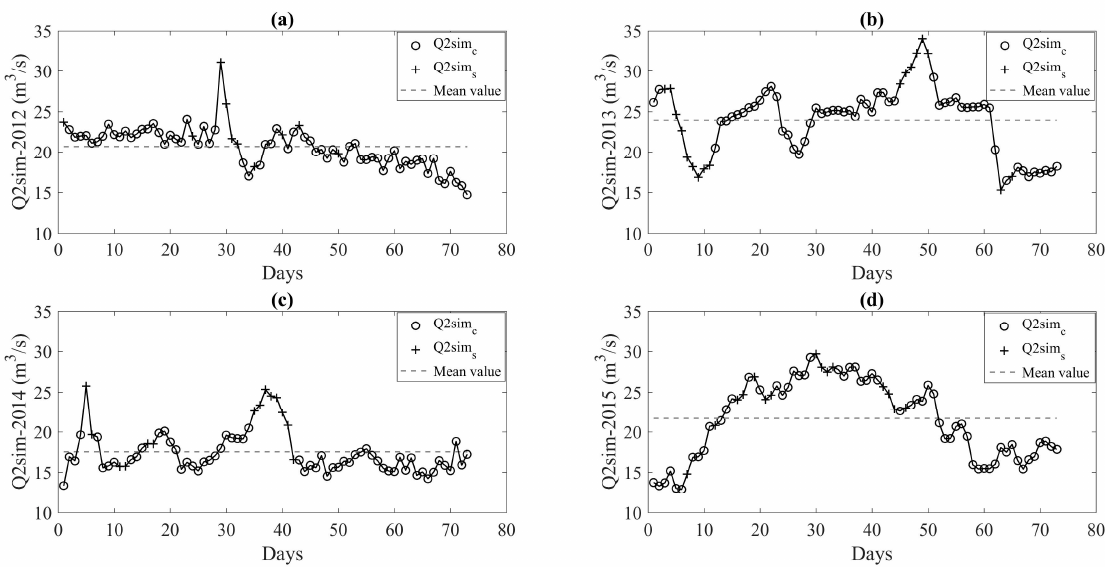
Figure 8. For every year: 2012 ( a ); 2013 ( b ); 2014 ( c ) and 2015 ( d ), the values of Q 2 sim obtained from the optimized model.